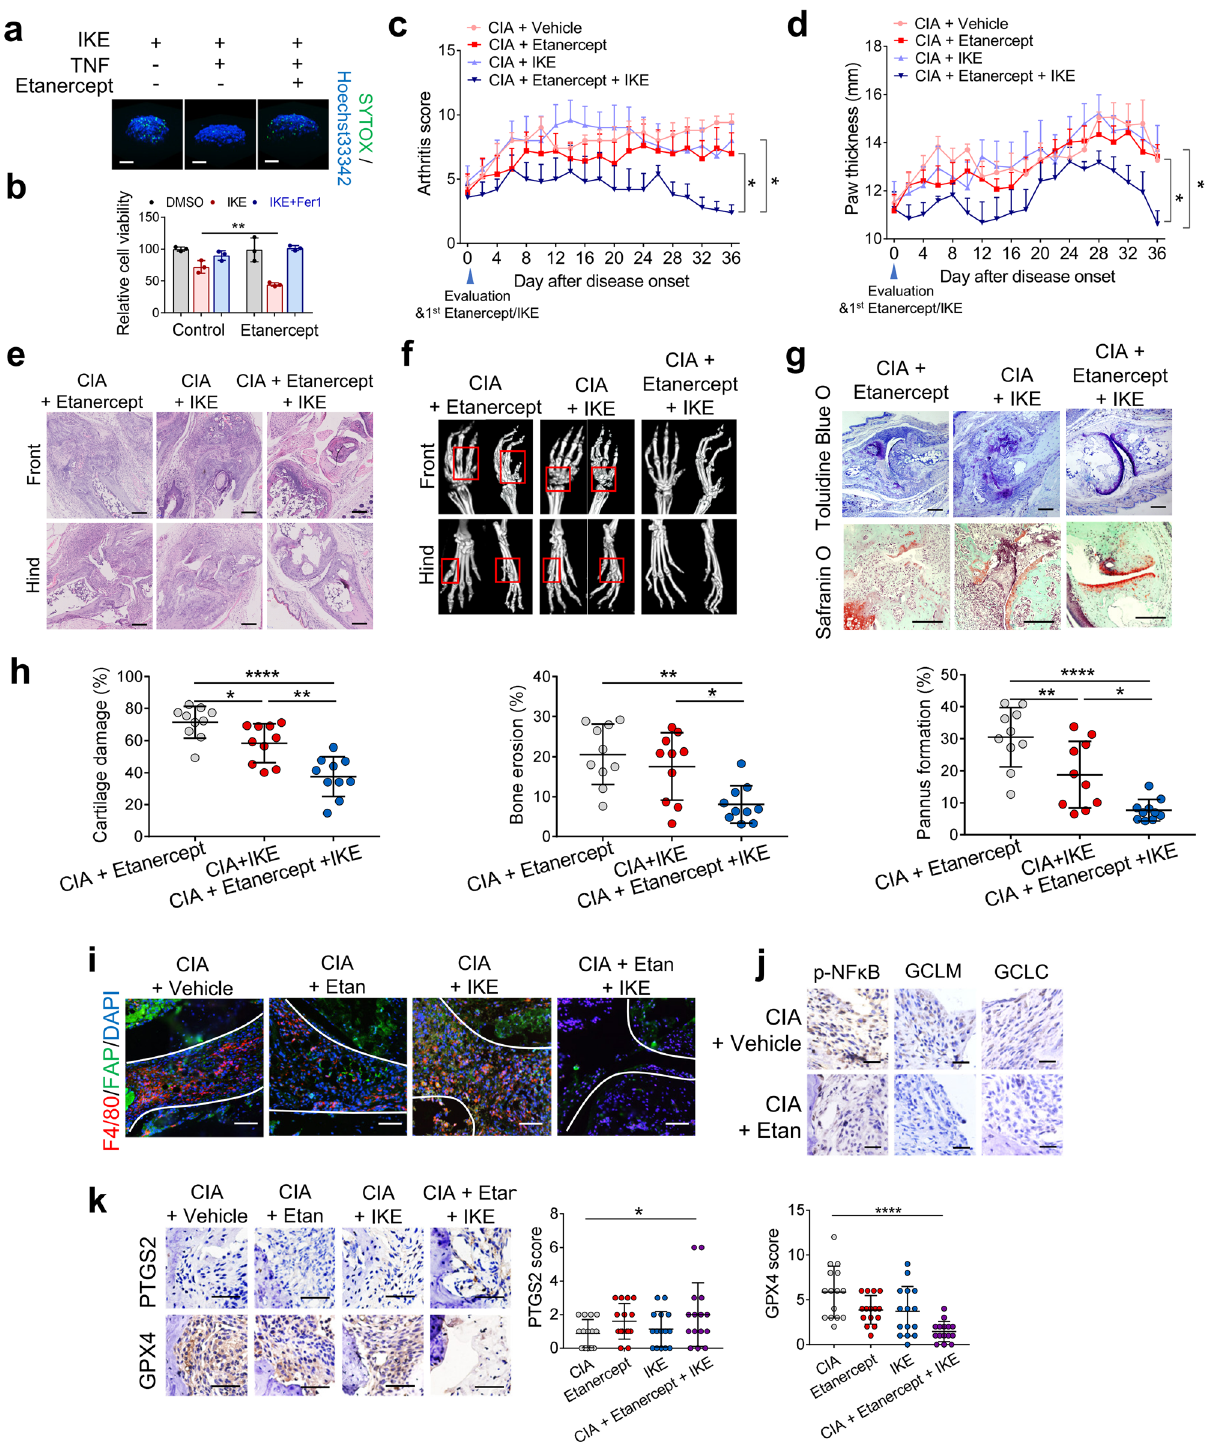
ferroptotic cell death might be a promising therapeutic approach for a wide range of diseases associated with dysregulated fi bro- blast